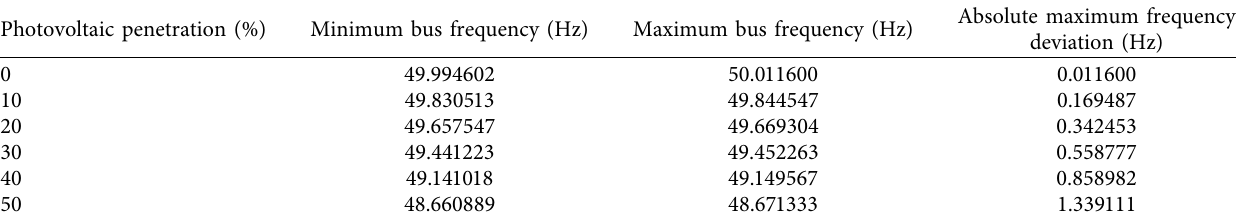
Figure 5: Frequency dynamics of node 1 and node 39 when different permeability fails. Table 1: Frequency dynamic response of the system when different PV permeability